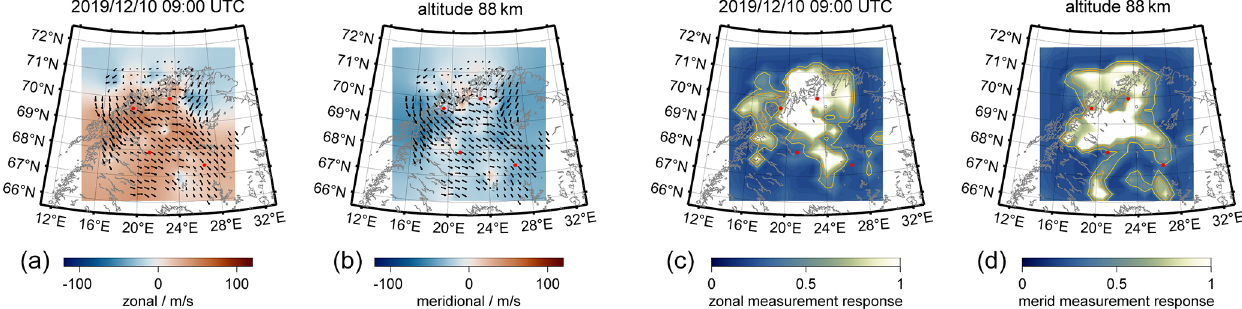
Figure 6. The same as Fig. 5 but for the Nordic Meteor Radar Cluster.